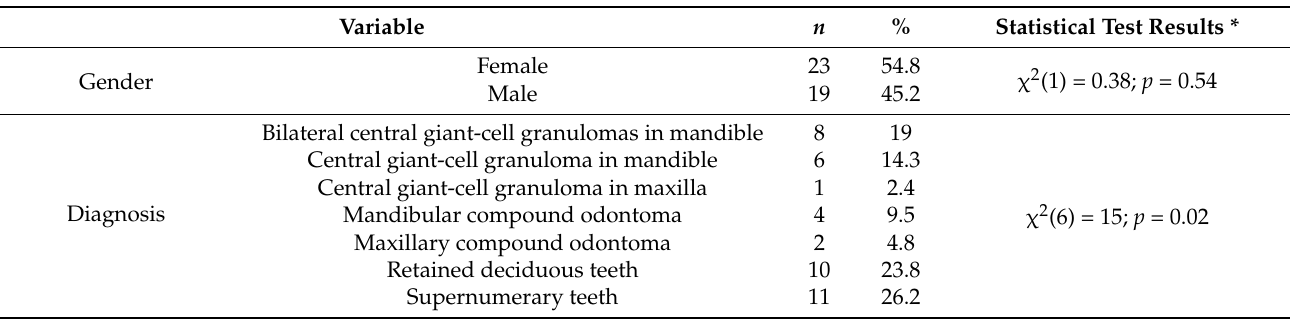
Table 1. Patient characteristics according to